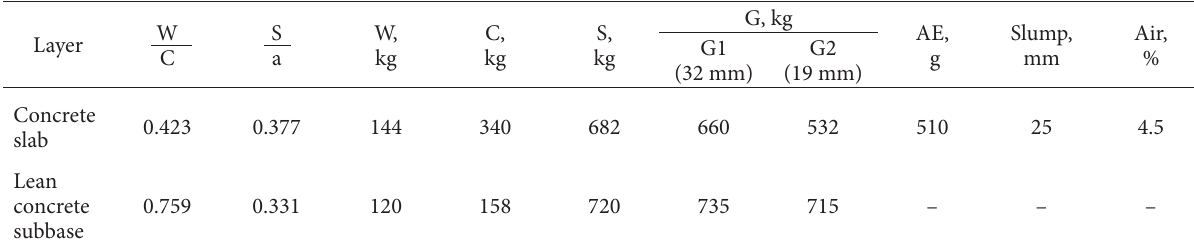
Table 1. Mixture proportion in 1 m 3 of